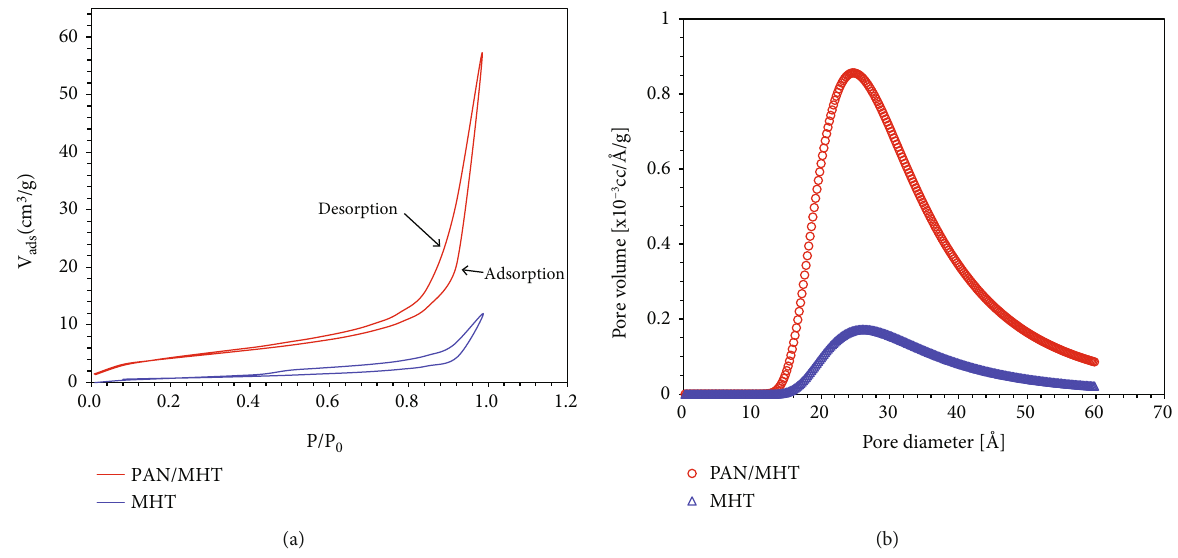
Figure 8: Nitrogen adsorption – desorption isotherms (a) and pore disstribution (b) of MHT and 2 Pan/MHT.